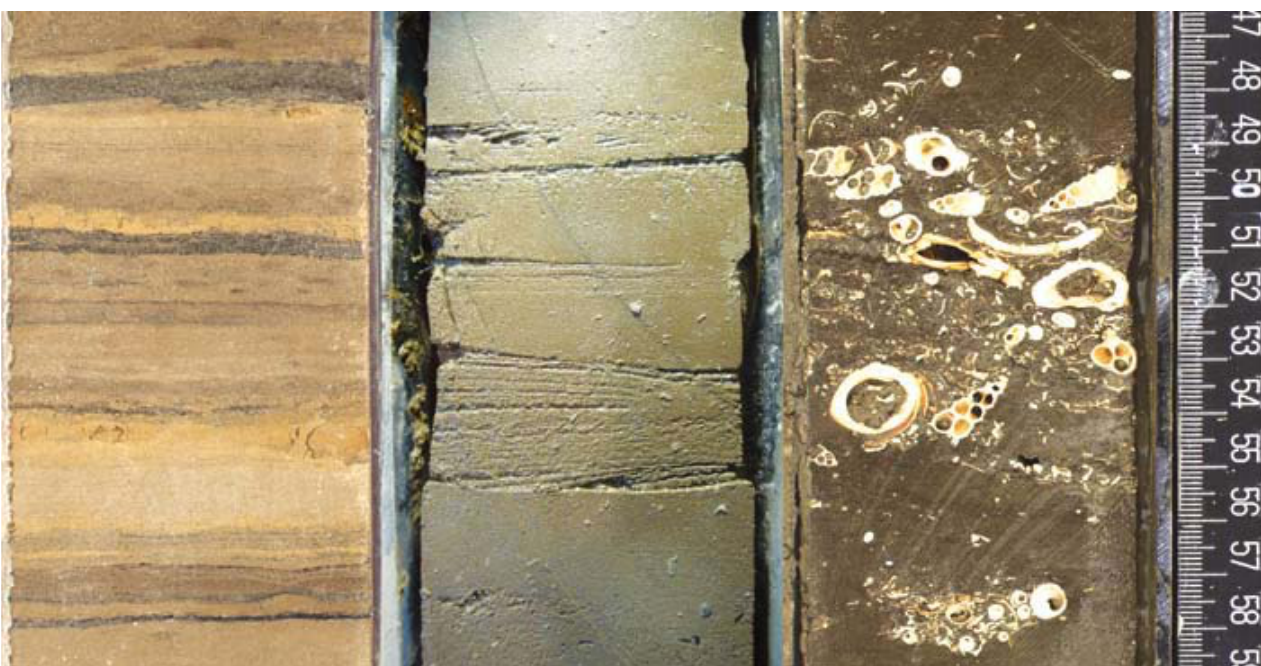
Figure 5. Close-up photographs of 3 split cores showing (from left to right): laminated silty clay from toeset beds seaward of a clinoform (Hole 28 core 166 sec 2); sharp-based sandy storm bed in sandy silt from topset beds (Hole 28 core 92 sec 1); and well-preserved gastropod and mollusk shells in silty offshore flooding surface (Hole 27 core 89 sec